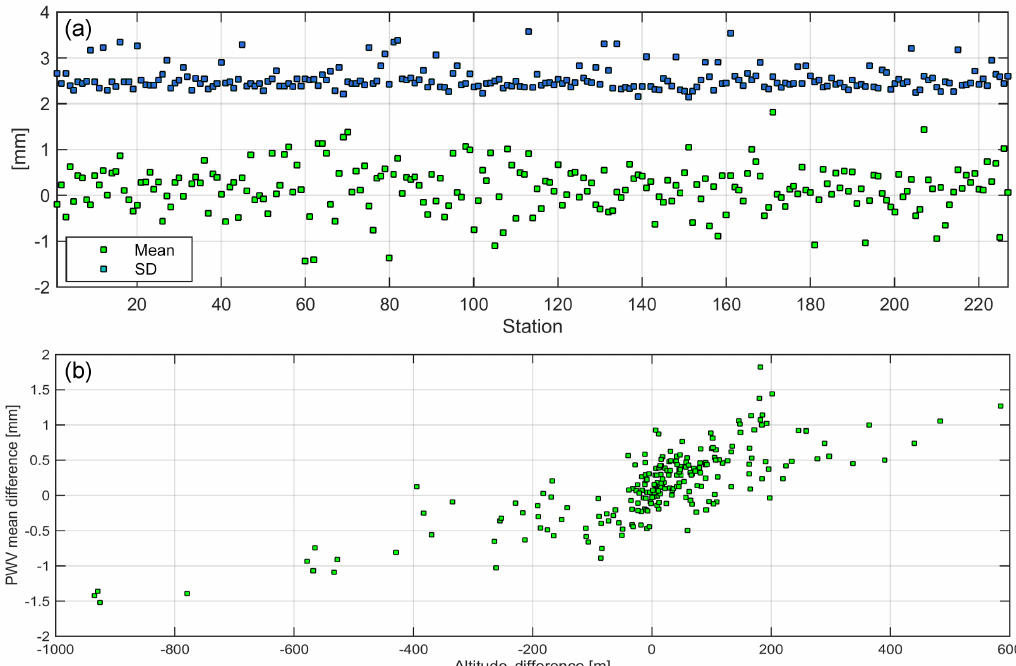
Figure 10. (a) Mean and standard deviation of the PWV time series difference (1991–2016) from ERA-Interim and synoptic data at 227 sta-